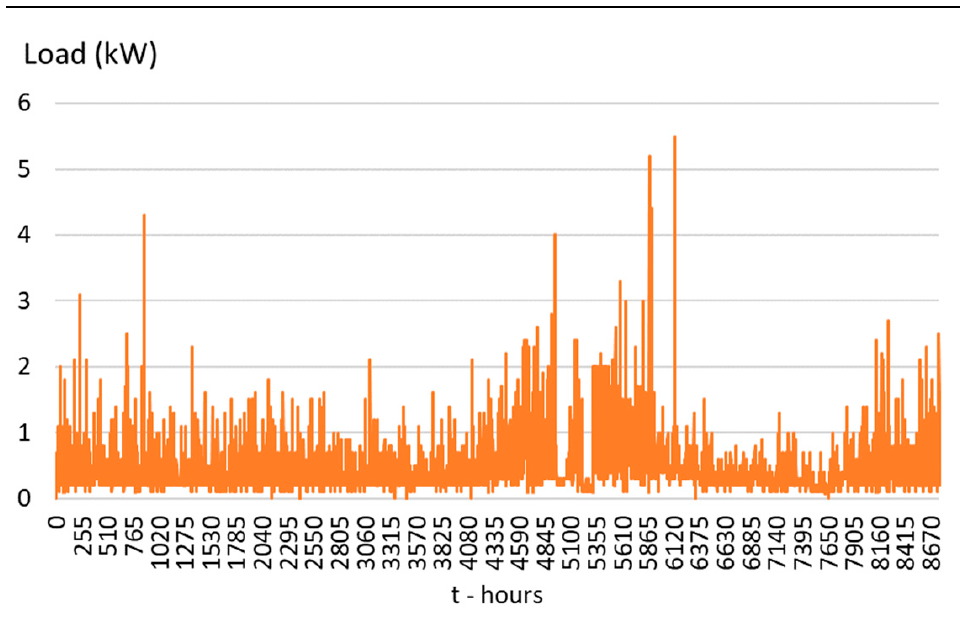
Figure 3. Annual domestic load demand. The seasonal variation in domestic demand can be seen from the indicative weeks presented in Figure